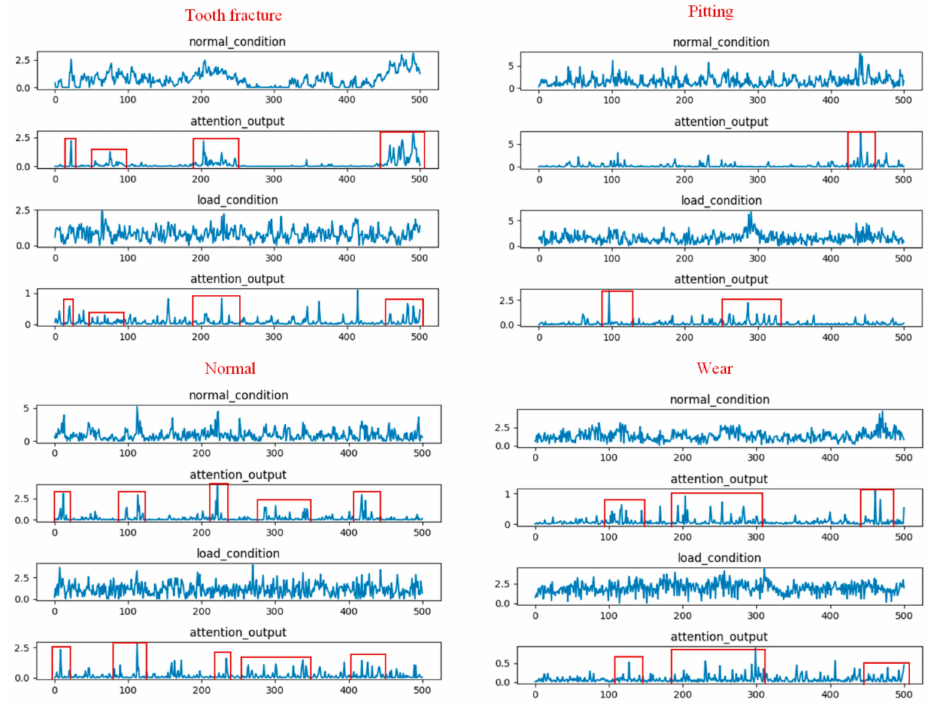
Figure 10. Visualization results of randomly selected filters from the multi-scale pool layer and temporal attention output for four di ff erent types of raw gear signals under the two load conditions corresponding to the attention based multi-scale CNN model for evaluation